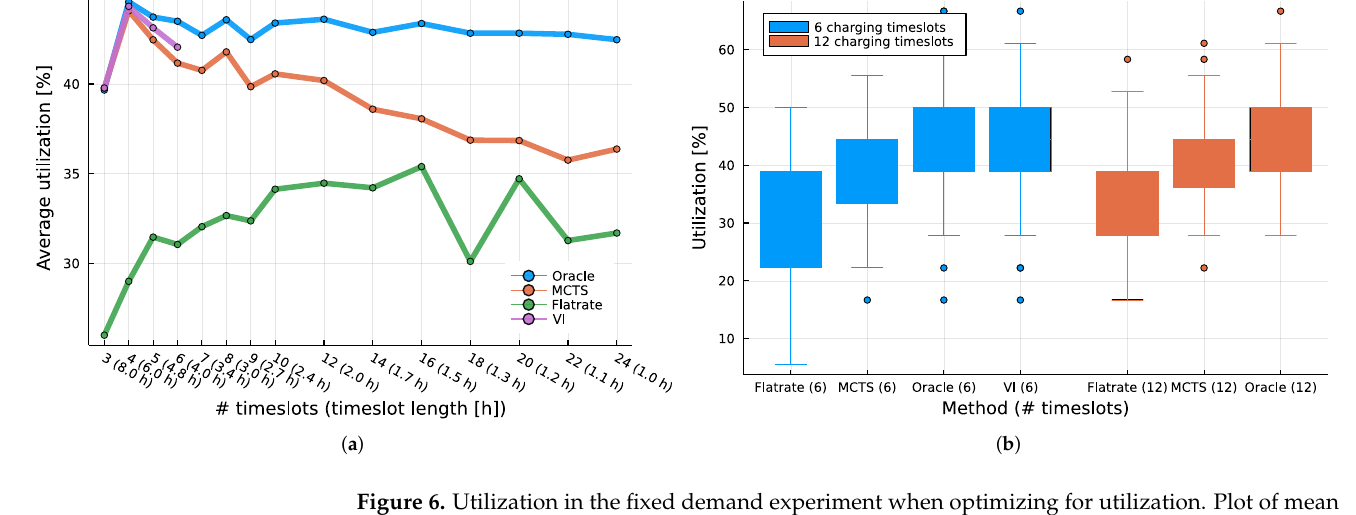
Figure 6. Utilization in the fixed demand experiment when optimizing for utilization. Plot of mean values for all instances is in ( a ) while the boxplot ( b ) shows problems with 6 and 12 timeslots only. We have fixed the expected number of charging hours while varying the number of timeslots in the 24 h selling period, K , across the different problem